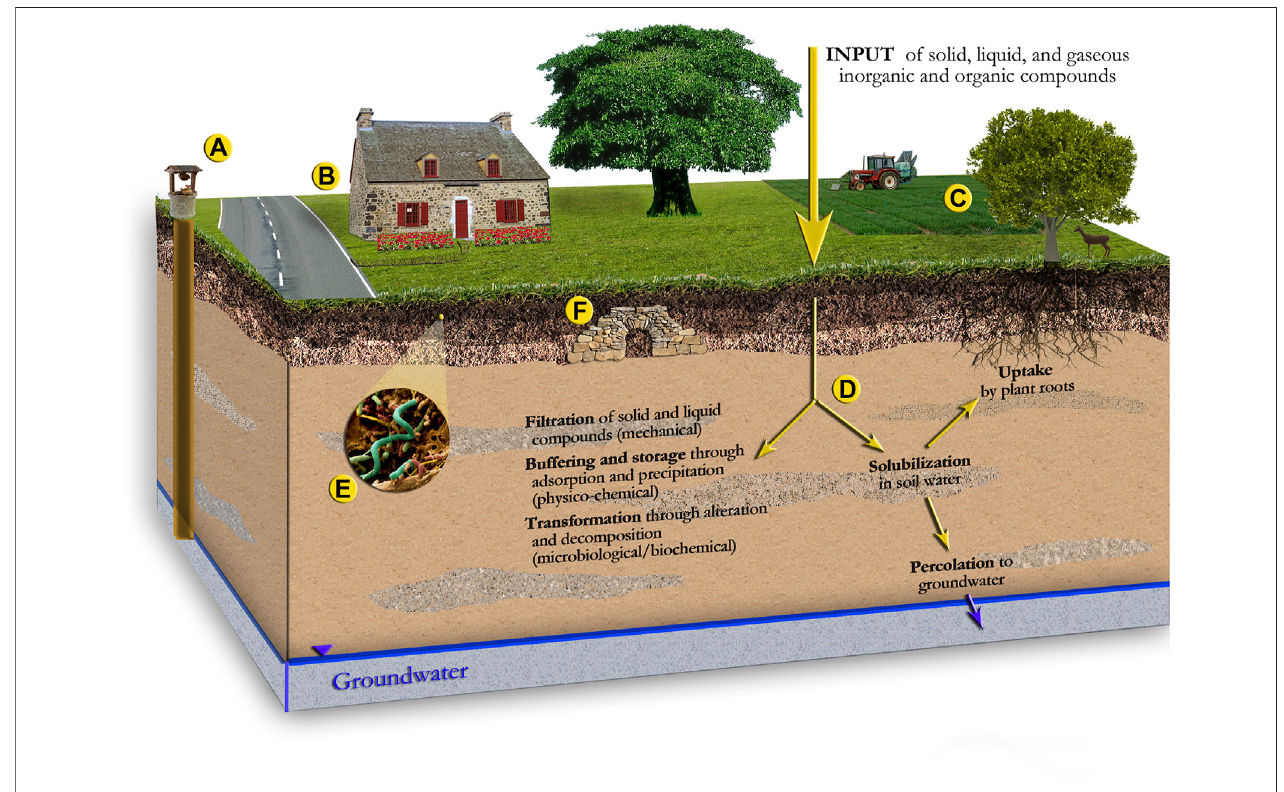
FIGURE 1 | Schematic illustration of the different functions of soils according to Blum (1988) classi fi cation. The six categories of soil functions correspond, respectively, to (A) the extraction of raw materials and water, (B) physically supporting buildings and other man-made structures, (C) the production of biomass, (D) fi ltration, buffering, storage, and chemical/biochemical transformations, and (E) the preservation of biodiversity or potentially useful genetic material, as well as of geogenic and cultural heritage (F) .